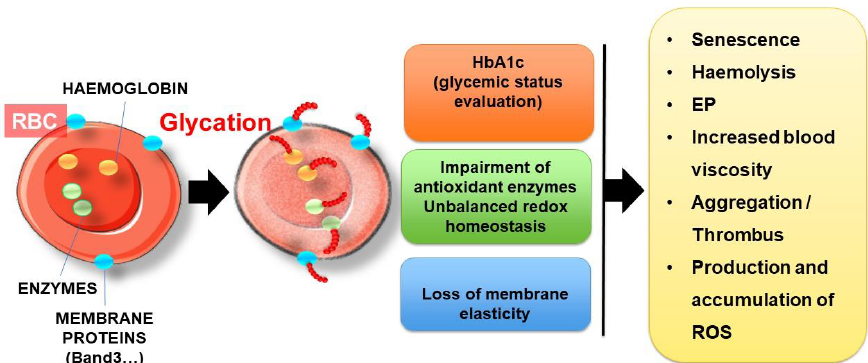
Figure 8. Deleterious effects of erythrocyte glycation. Hyperglycaemia causes glycation of many RBC components, such as haemoglobin, antioxidant enzymes and cell surface membrane proteins. This phenomenon induces unbalanced redox homeostasis with the loss of membrane elasticity. As a consequence, erythrocyte senescence, haemolysis, EP, erythrocyte aggregation and ROS production are enhanced.